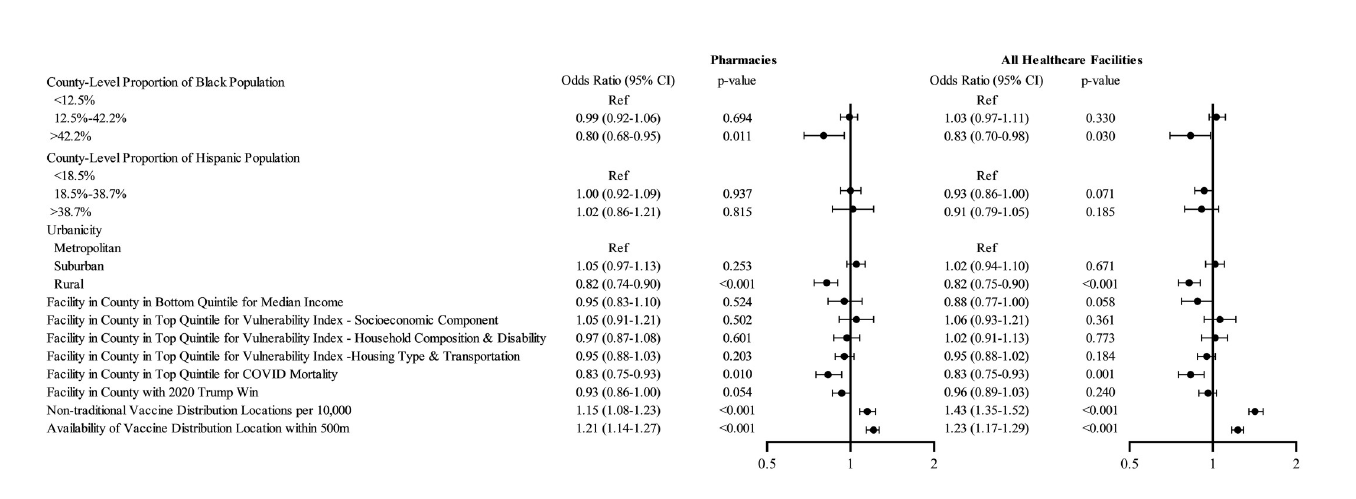
Fig 1. Adjusted odds ratios of facilities serving as COVID-19 vaccine administration locations, main effects. The figure shows the results of logistic regression models fitted with generalized estimating equations for the primary outcome of a healthcare facility (or a pharmacy) serving as a COVID-19 vaccine administration location. The model only included main effects. All healthcare facilities included pharmacies, FQHCs, RHCs, and HODs. The circles represent the point estimate for the odds ratio, and the whiskers represent the 95% confidence interval. COVID AU : AbbreviationlistshavebeencompiledforthoseusedinFigs 1 (cid:0) 3 : Pleaseverifythatallentriesarecorrect : -19, Coronavirus Disease 2019; FQHC, federally qualified health center; HOD, hospital outpatient department; RHC, rural health